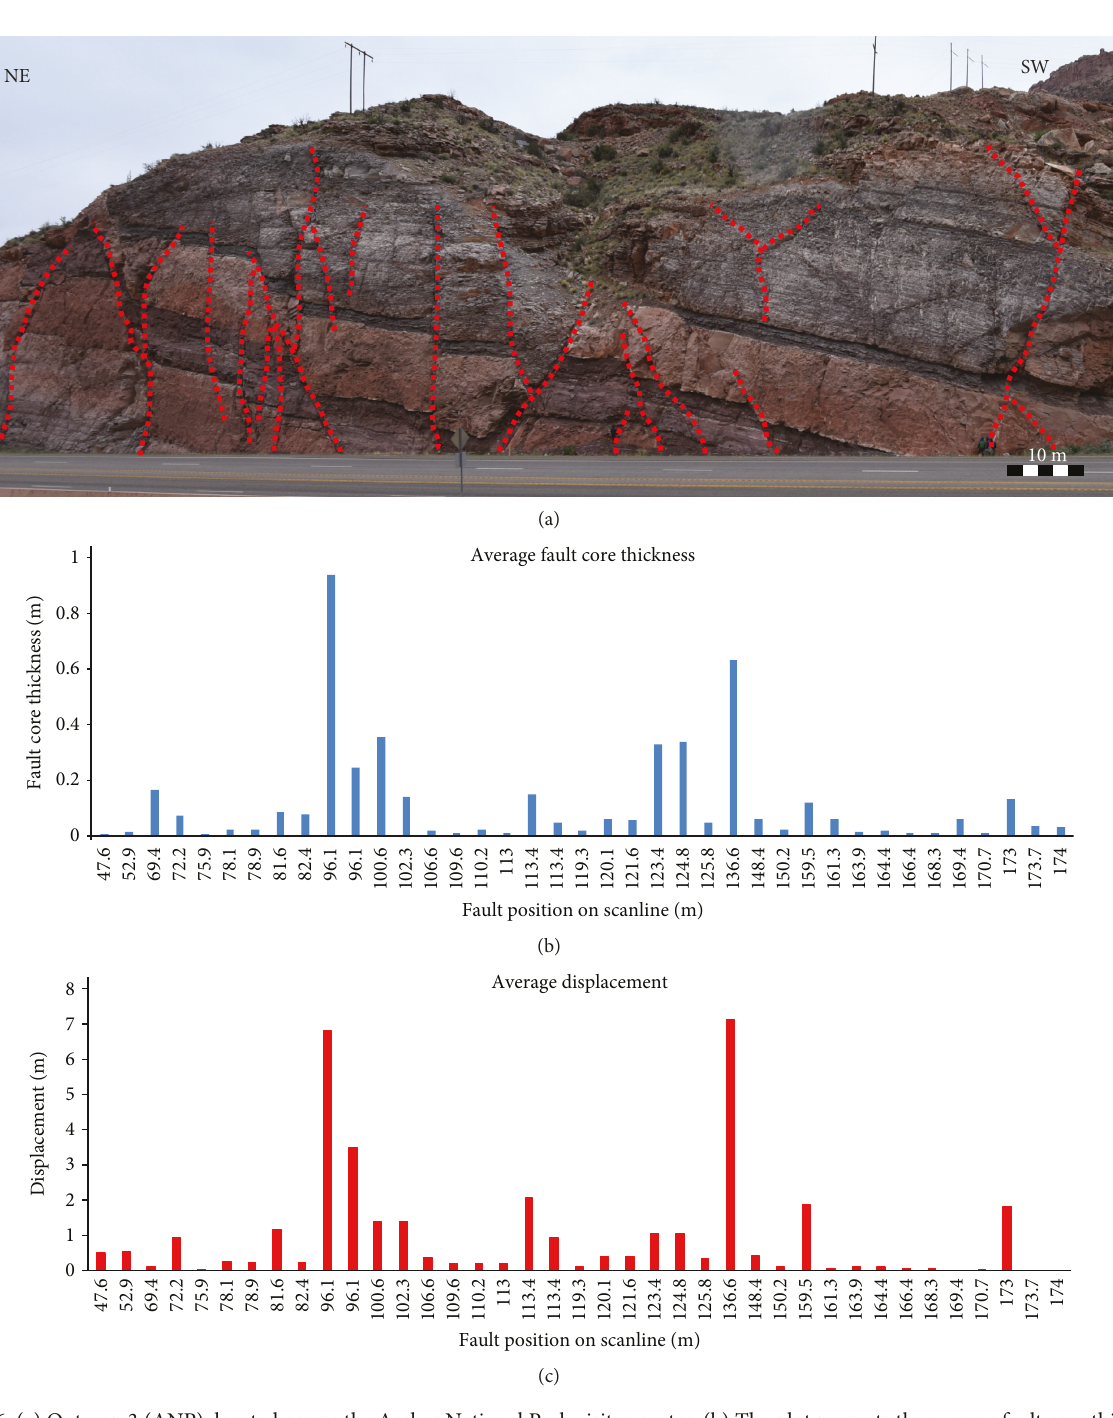
Figure 6: (a) Outcrop 3 (ANP), located across the Arches National Park visitor center. (b) The plot presents the average fault core thickness for each fault. (c) The plot presents the average displacement values for the corresponding